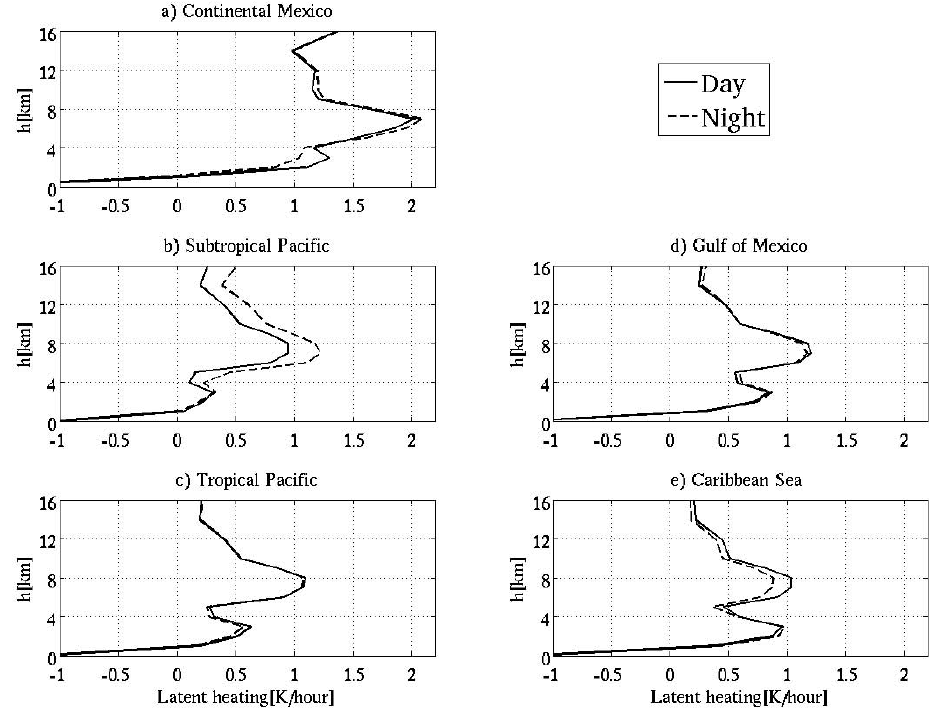
Fig. 5. Similar to Fig. 4 but for the latent